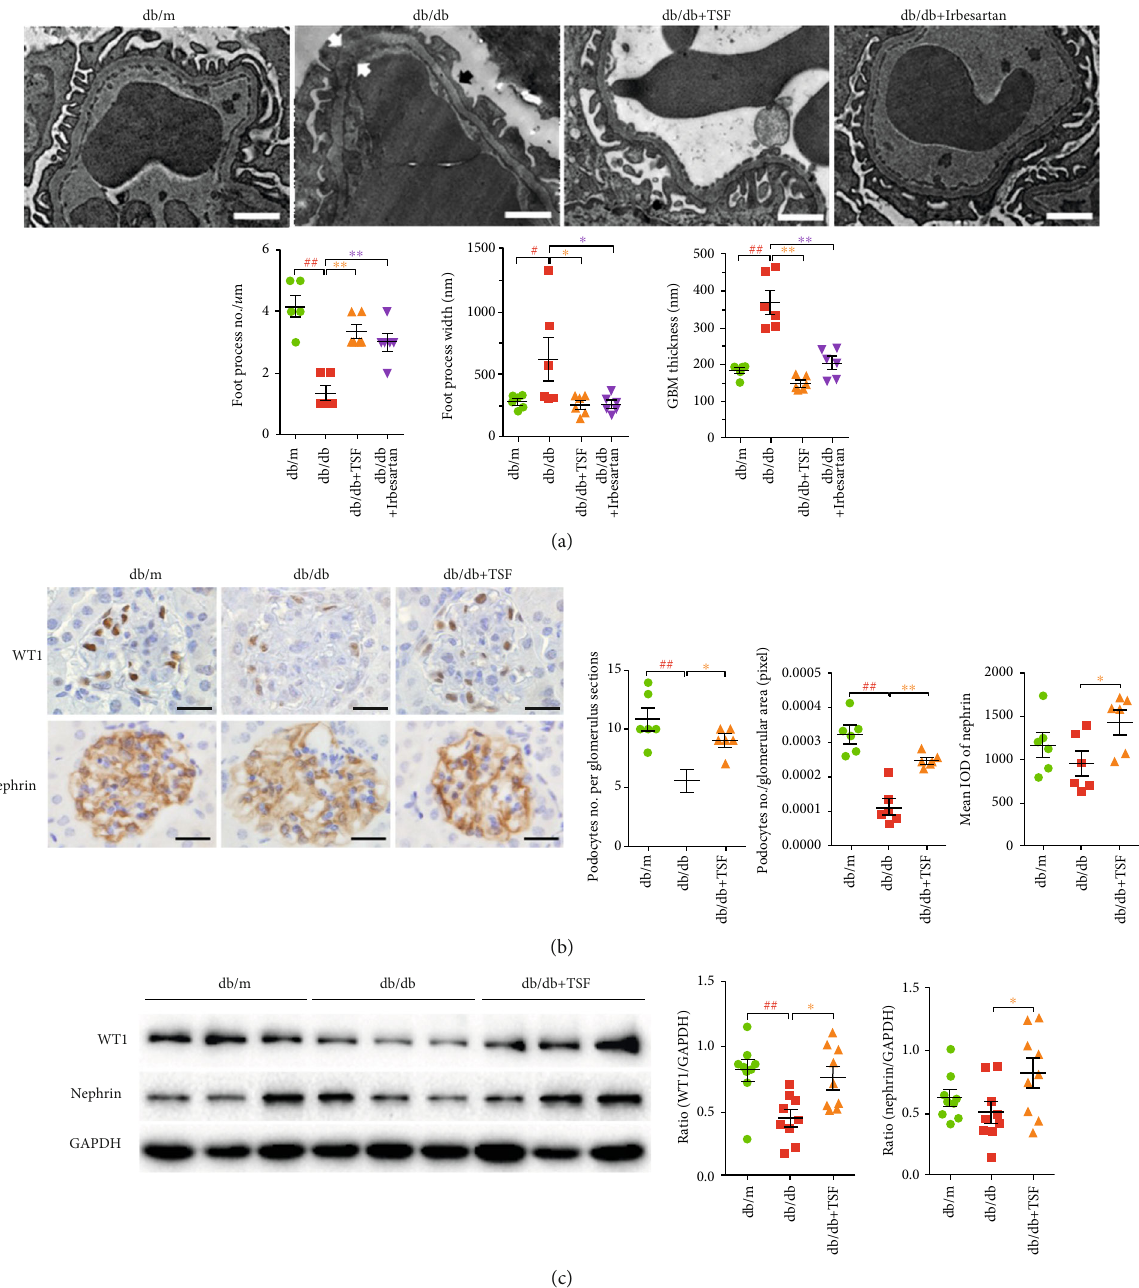
Figure 2: TSF reduced foot process e ff acement, prevented WT1 from loss in db/db mice. (a) Representative transmission electron micrographs (scale bars, 1 μ m) illustrate foot process e ff acement (black arrow) and GBM thickness (white arrow); the number and width of foot process and GBM thickness were subsequently calculated ( n = 6 ). (b) Representative immunohistochemical staining and quantitative analysis of WT1 and nephrin (scale bars, 20 μ m) (20 glomeruli were randomly evaluated per section, n = 6 ). (c) Immunoblotting for WT1 and nephrin; quanti fi cation of the gels is shown on the right ( n = 3 experiments). The data were expressed as the mean ± SEM . # P < 0 : 05 , ## P < 0 : 01 vs. db/m group; ∗ P < 0 : 05 , ∗∗ P < 0 : 01 vs. db/db group. Statistically analyzed via a one-way ANOVA with Dunnett ’ s